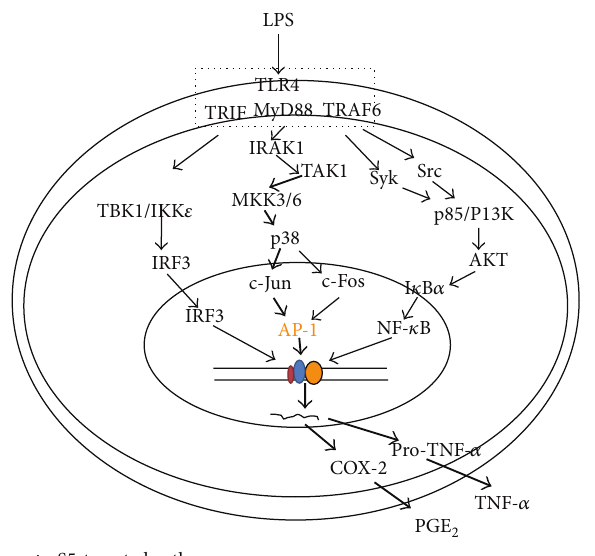
Figure 5: Anti-inflammatory effects of the S5 peptide on signaling